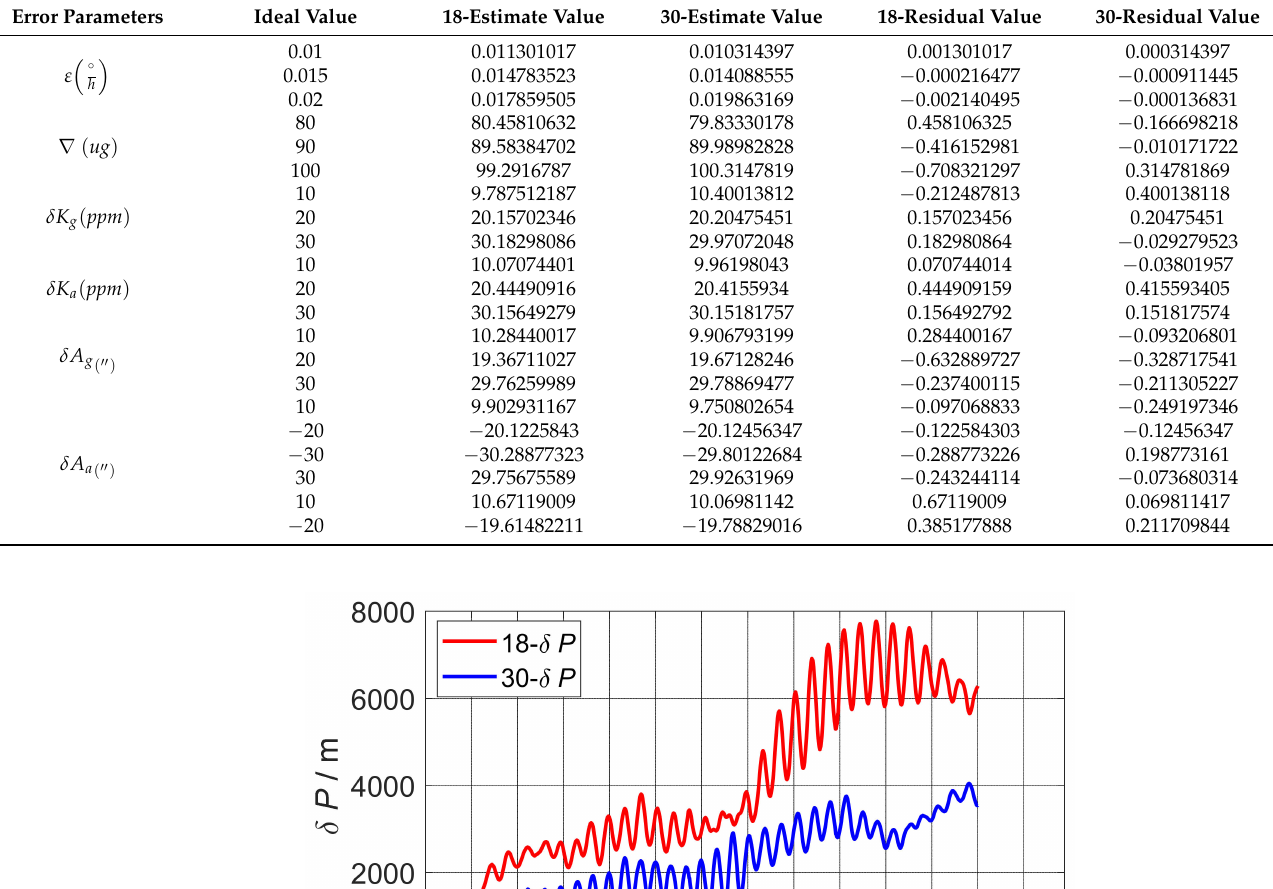
Table 3. The error parameter estimation results in simulation.